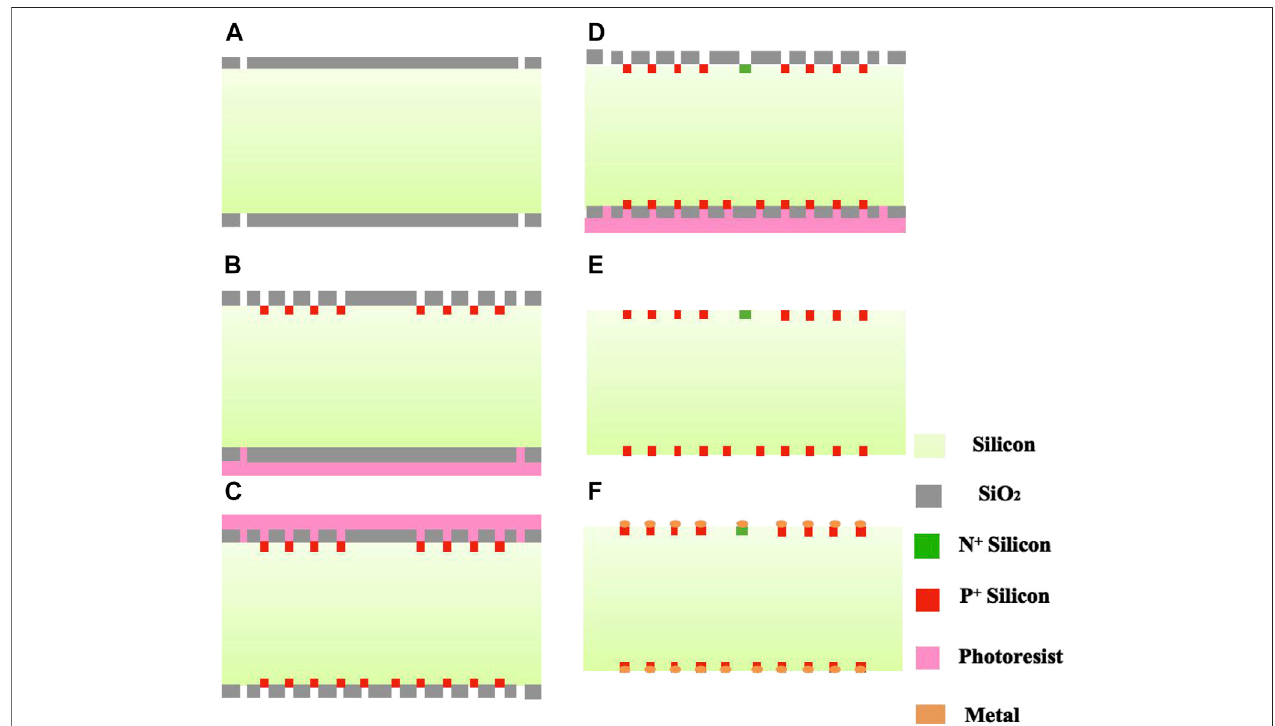
FIGURE 5| Simpli fi ed process fl ow chart. (A) Formation of the double-sided photo lithography marks; (B) the front side photo lithography and P+ ion implantation withprotectionofthebackside; (C) thebacksidephotolithographyandP+ionimplantation; (D) thefrontsidephotolithographyandN+ionimplantationwithprotection of the back side; (E) annealing and deoxidation; and (F) metallization and surface passivation.